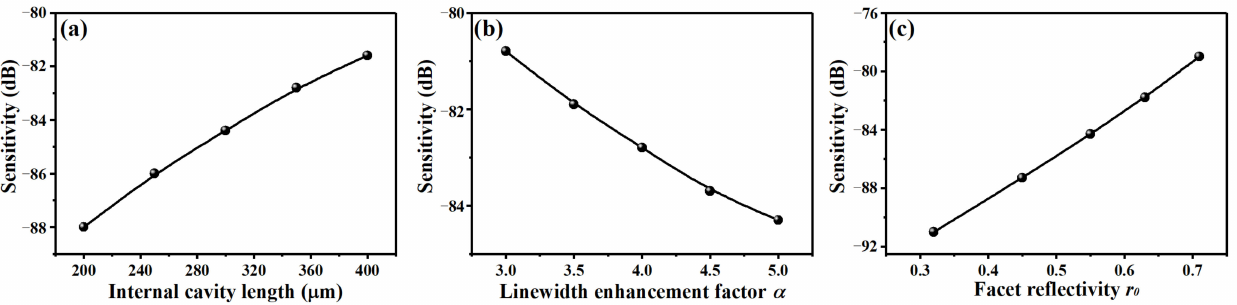
Figure 5. Effects of laser parameters on sensitivity: ( a ) internal cavity length; ( b ) linewidth enhance- ment factor; ( c ) facet